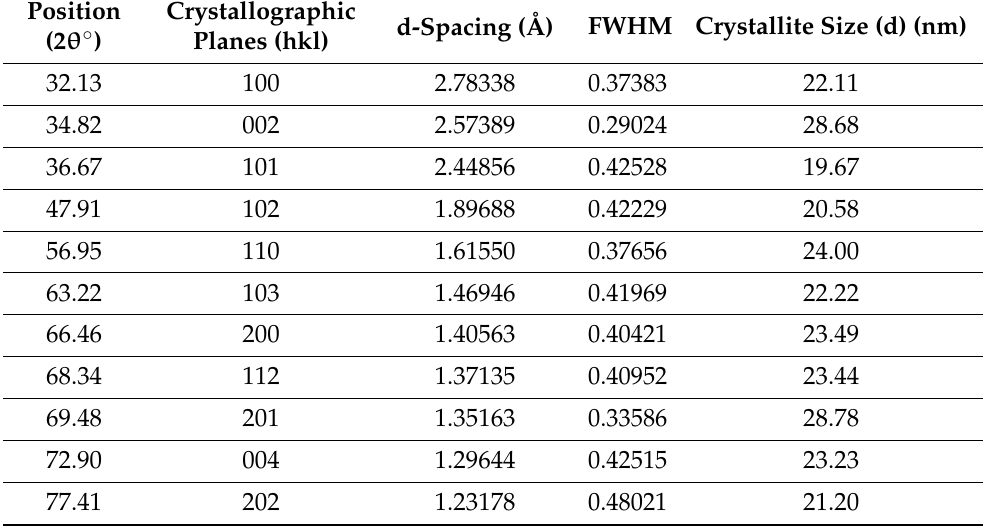
Table 1. XRD data and crystallite size of ZnO